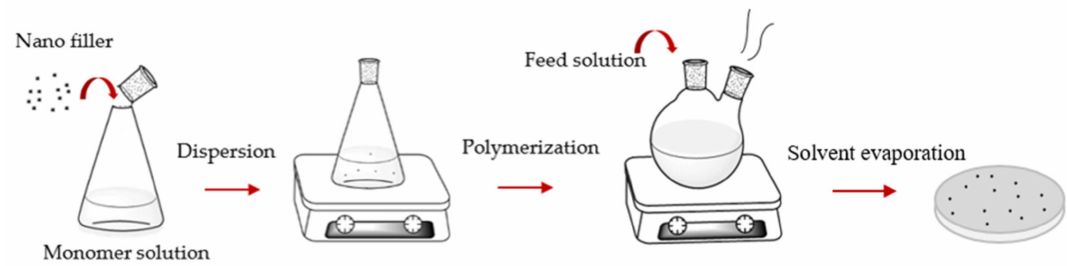
Figure 5. Schematic representation of in situ